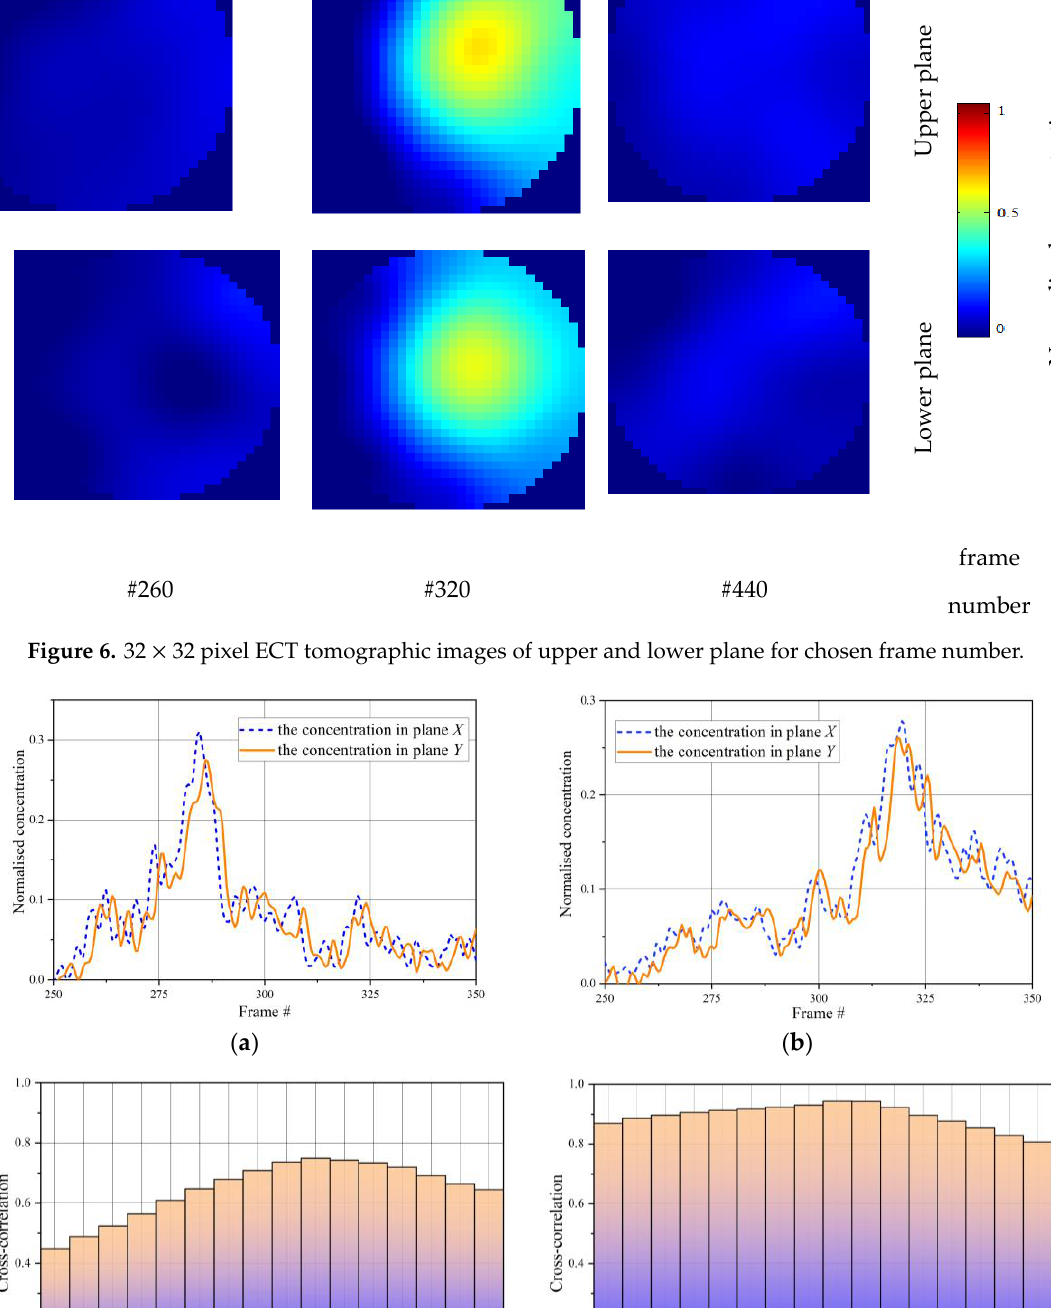
Figure 6. 32 × 32 pixel ECT tomographic images of upper and lower plane for chosen frame number.